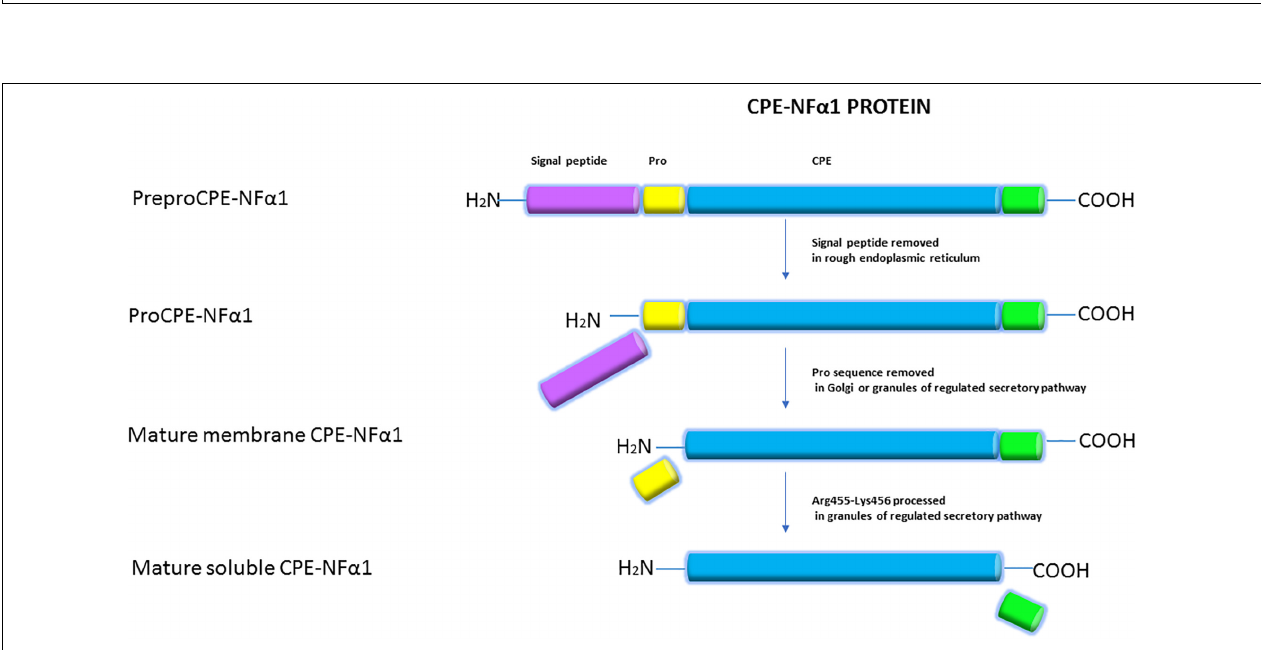
Frontiers in Neuroscience |